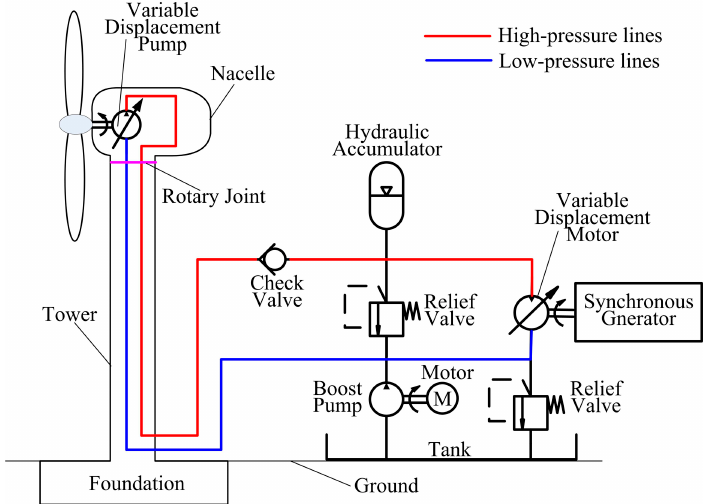
Figure 1. Schematic diagram of the closed hydraulic wind turbine with energy storage system.